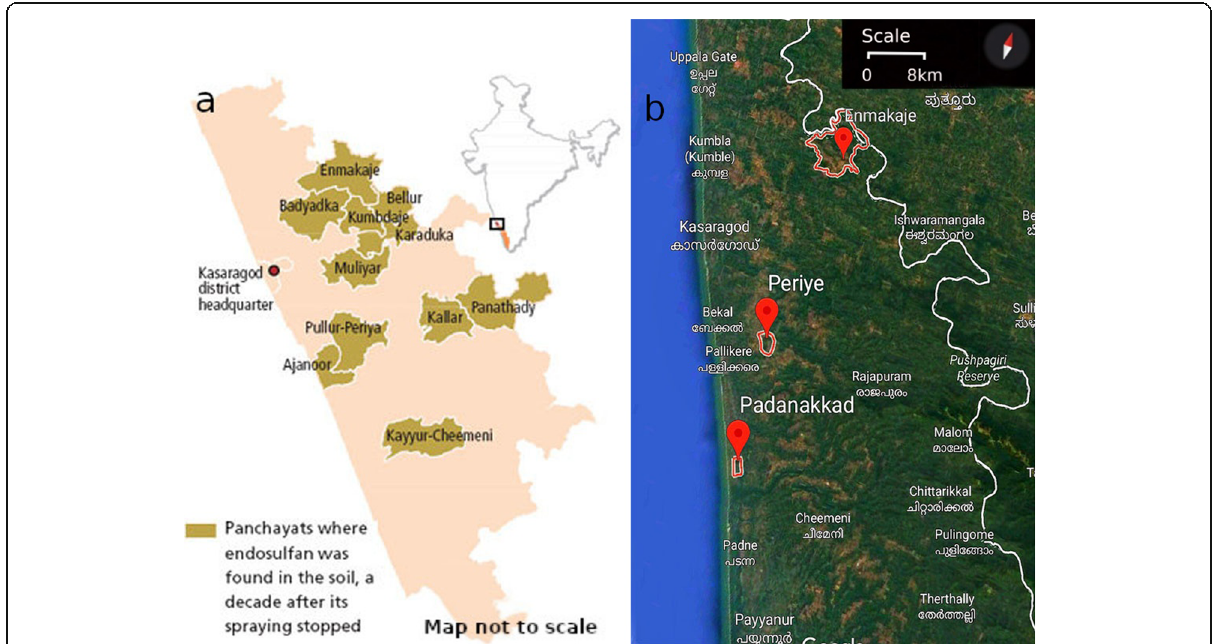
Fig. 1 Kasaragod map from Kerala State, India, showing ( a ) endosulfan-affected areas (Misra, 2015), ( b ) study areas: Enmakaje — highly affected area, Periye — moderately affected area, Padanakkad — unaffected area (Google map figure, n.d.). Note: Enmakaje and Periye are the places that lie under Enmakaje and Pullur-Periye panchayaths